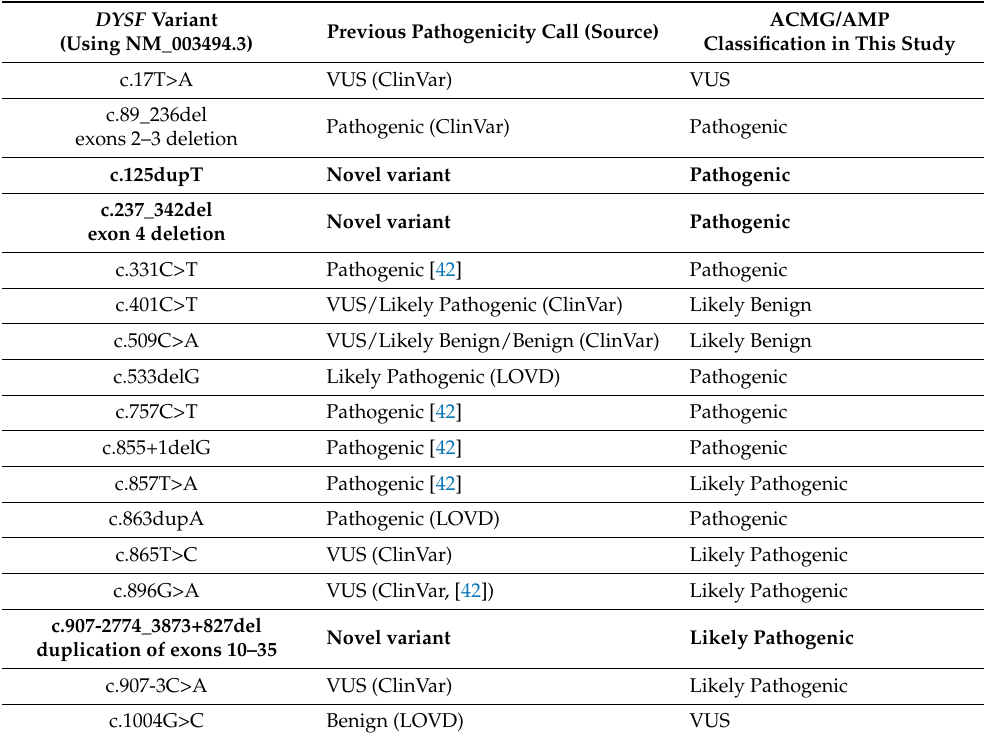
Table 2. ACMG/AMP classification of DYSF variants identified in this study. DYSF Variant (Using